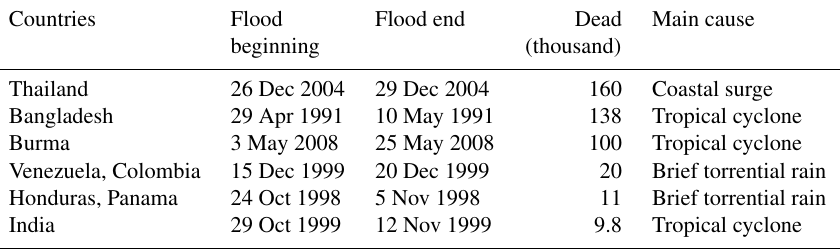
Table 1. Six most deadly floods (including coastal surges) worldwide since 1985. Information from Dartmouth Flood Observatory. Countries Flood Flood end Dead Main